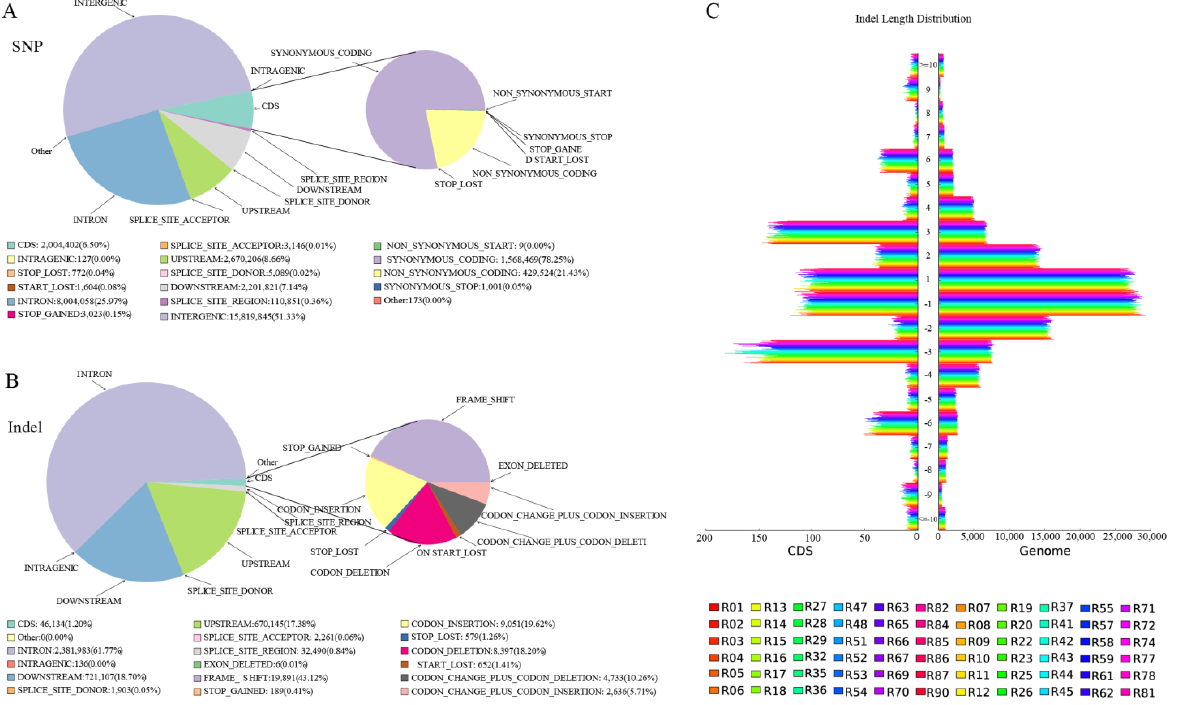
Figure 2. Genome variations, annotation, and indel length distribution map in CDS, condign area, and the whole genome. ( A ) A plot of all SNP annotations. ( B ) A plot of all indel annotation distributions. ( C ) Indel length distribution in CDS and the genome. The longitudinal Y-axis coordinates are indel lengths (within 10 bp); greater than 0 is an insertion and less than 0 is a deletion. The horizontal X-axis coordinates are the corresponding quantities. R represents resistance and S represents the susceptibility of 90 samples in the three populations of A. c. cerana .